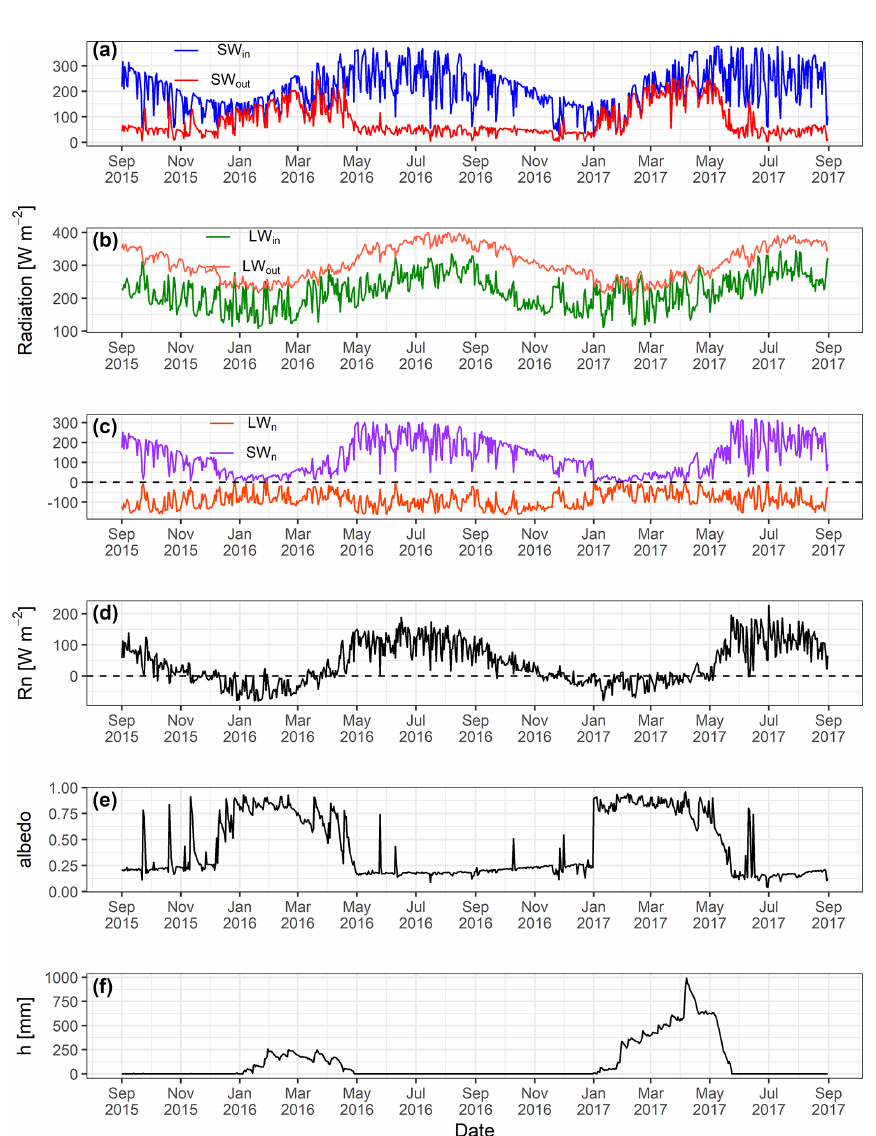
Figure 6. Observed daily mean values of (a) incoming (SW in ) and outgoing (SW out ) short-wave radiation, (b) incoming (LW in ) and outgoing long-wave (LW out ) radiation, (c) net short-wave (SW n ) and long-wave radiation (LW n ), and (d) net radiation ( R n ), (e) surface albedo and (f) snow depth ( h , mm) at South Pullu (4727ma.s.l.) from 1 September 2015 to 31 August